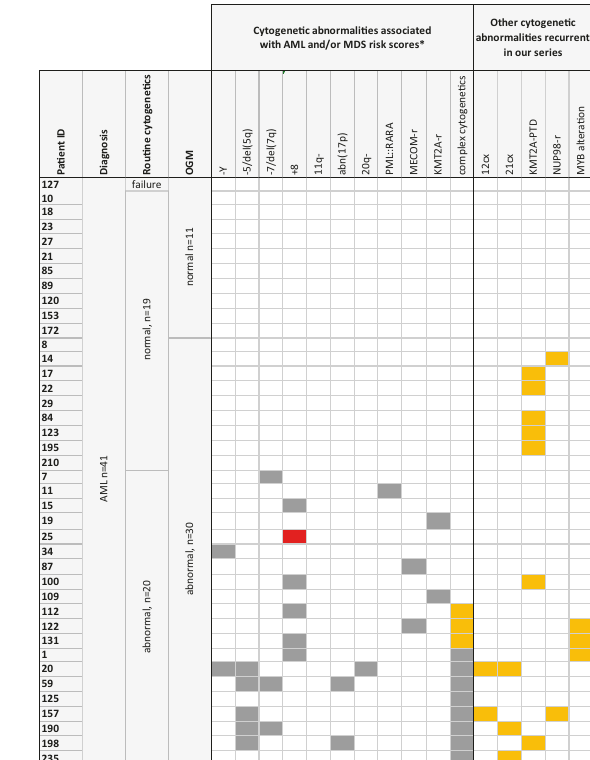
Cytogene(cid:2)c abnormali(cid:2)es associated with AML and/or MDS risk scores*